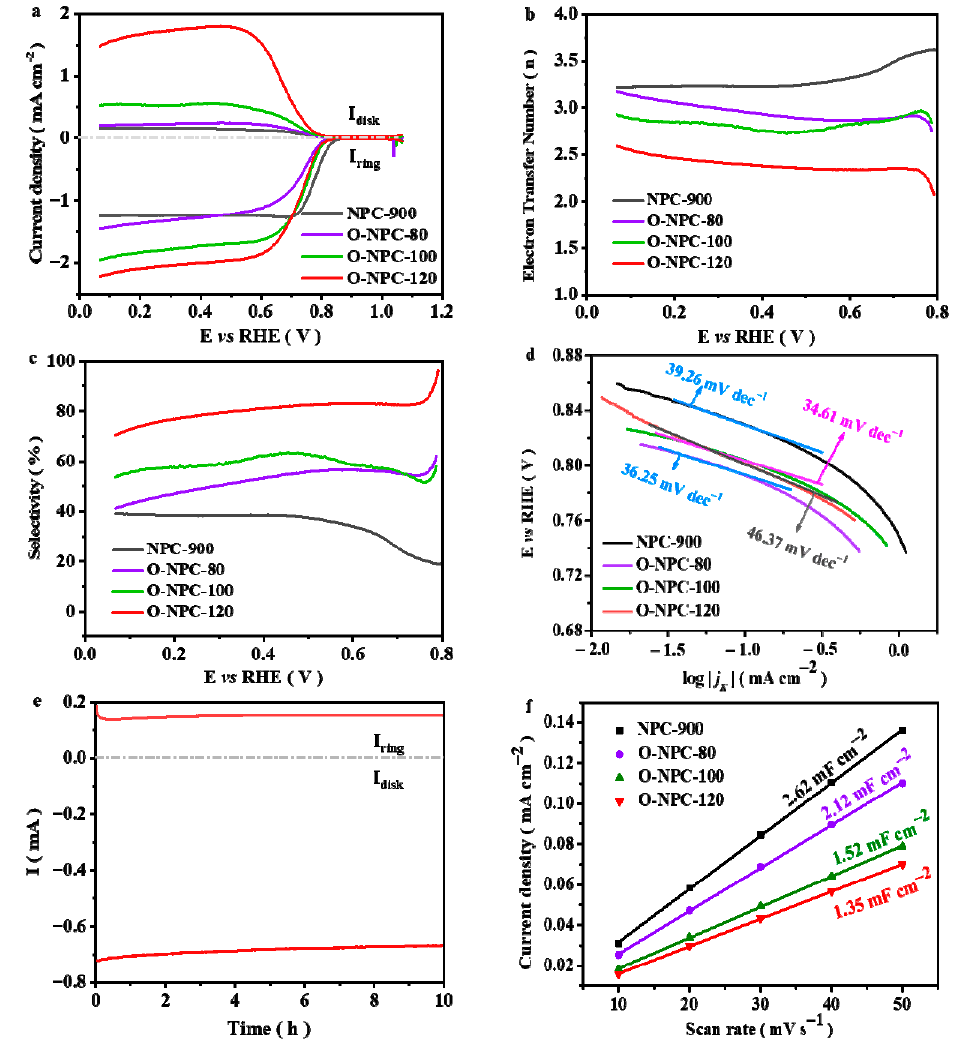
Figure 2. The catalyst ORR property in KOH electrolyte (0.1 M): ( a ) The catalyst RRDE polarization curves at 1600 rpm and a scan rate of 10 mV s − 1 . Current density was normalized to loading and BET. ( b ) Electron transfer number and ( c ) H 2 O 2 selectivity of catalysts. ( d ) Tafel slope of catalysts. ( e ) Stability test of O-NPC-120 at a fixed disk potential of 0.36 V. ( f ) The capacitance current densities (obtained from Figure S4) tested at 0.963 V (vs. RHE) as a function of scanning rate. The slope value refers to the double-layer capacitance (C dl ).